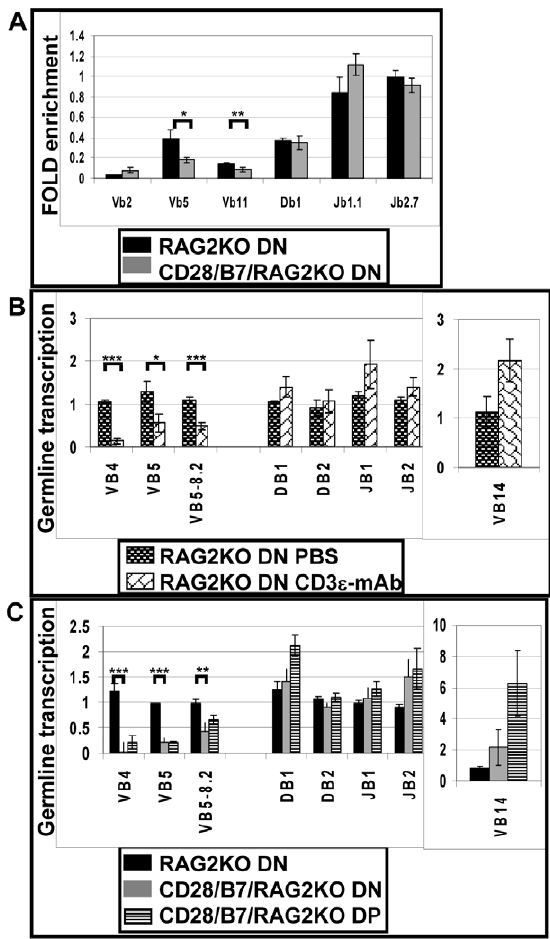
Figure 6. Accessibility of DJ b and V b regions are differentially regulated during thymic development. (A) Fold-enrichment H3K4Me3 analyzed by ChIP for V b (2, 5, and 11) D b 1, and J b (1.1 and 2.7) regions. Each data point represents the mean 6 SEM of six independent lysates prepared from RAG2KO (black bar) or CD28/B7/ RAG2KO (grey bar) DN cells. H3K4Me3 of b -actin was used as a normalization control. (B) Relative germline transcription of the unrearranged TCR b region in RAG2KO DN cells from mice previously injected with either PBS (dark brick bar) or CD3 e mAb (open brick bar). These results represent the mean 6 SEM of three to five mice per group analyzed in two separate experiments. (C) Relative germline transcrip- tion of the unrearranged TCR b region in RAG2KO DN cells (black bar), CD28/B7/RAG2KO DN cells (grey bar) or CD28/B7/RAG2KO DP cells (black striped bar). These results represent the mean 6 SEM of five to six mice per genotype analyzed in two separate experiments. For both (B) and (C) data shown are normalized to transcription measured in RAG2KO DN cells using b -actin transcription as a loading control for each group. For (A), (B), and (C) the order of the data points reflects the 5 9 –3 9 genomic organization of the TCR b region and brackets identify comparisons that are significantly different (p , 0.05): * indicates p # 0.03, ** indicates p # 0.02, and *** indicates p # 0.001.